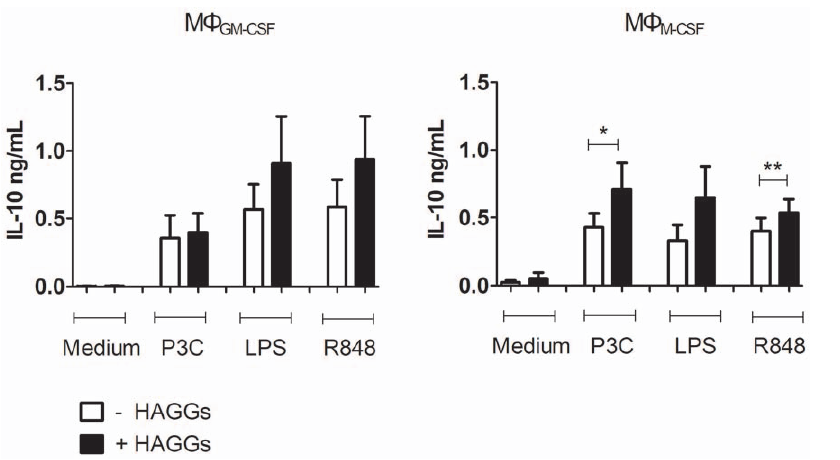
Figure 5. IL-10 production by M W GM-CSF and M W M-CSF after stimulation with HAGGs and TLR ligands. Healthy peripheral blood monocytes were cultured for 4 days in medium supplemented with GM-CSF or M-CSF. M W GM-CSF and M W M-CSF were not stimulated, or stimulated for 20 hours with P3C, LPS, or R848, in the presence or absence of HAGGs. Bars represent the mean 6 SEM of 6 independent experiments. *p , 0.05, **p , 0.01.